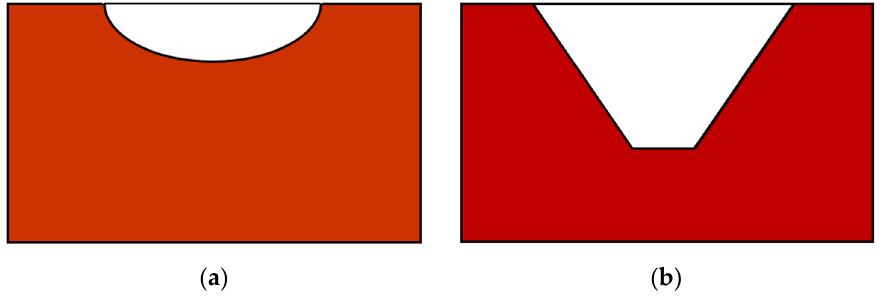
Figure 1. Shape of disc groove: ( a ) Semi-elliptical; ( b ) Trapezoidal. Disc specifications, such as the number of stacked discs, disc diameter, and number and length of grooves, were analyzed in this study. The depth, width, and cross-sectional